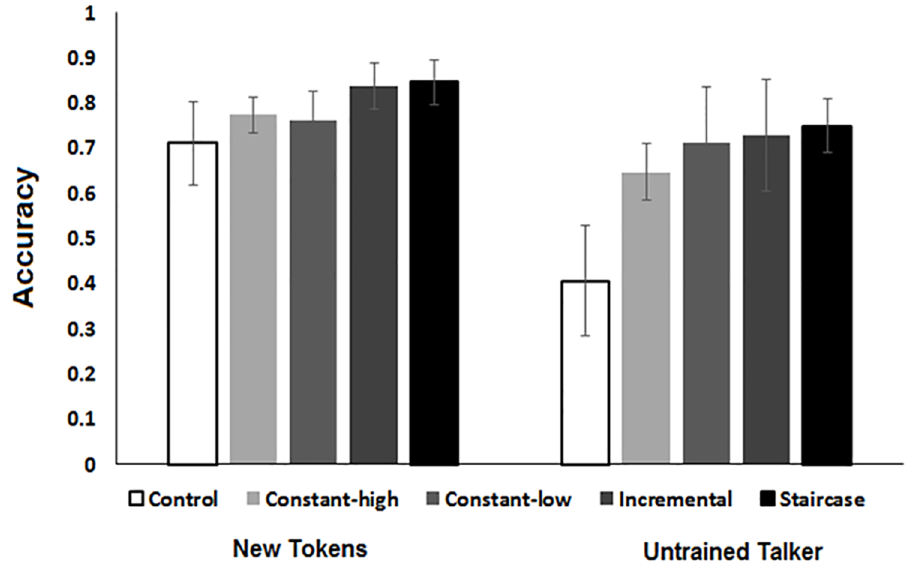
Fig 3. Posttests performance on the new tokens and new talker conditions as a function of training protocol. Error bars show the 95% confidenceinterval of the mean.